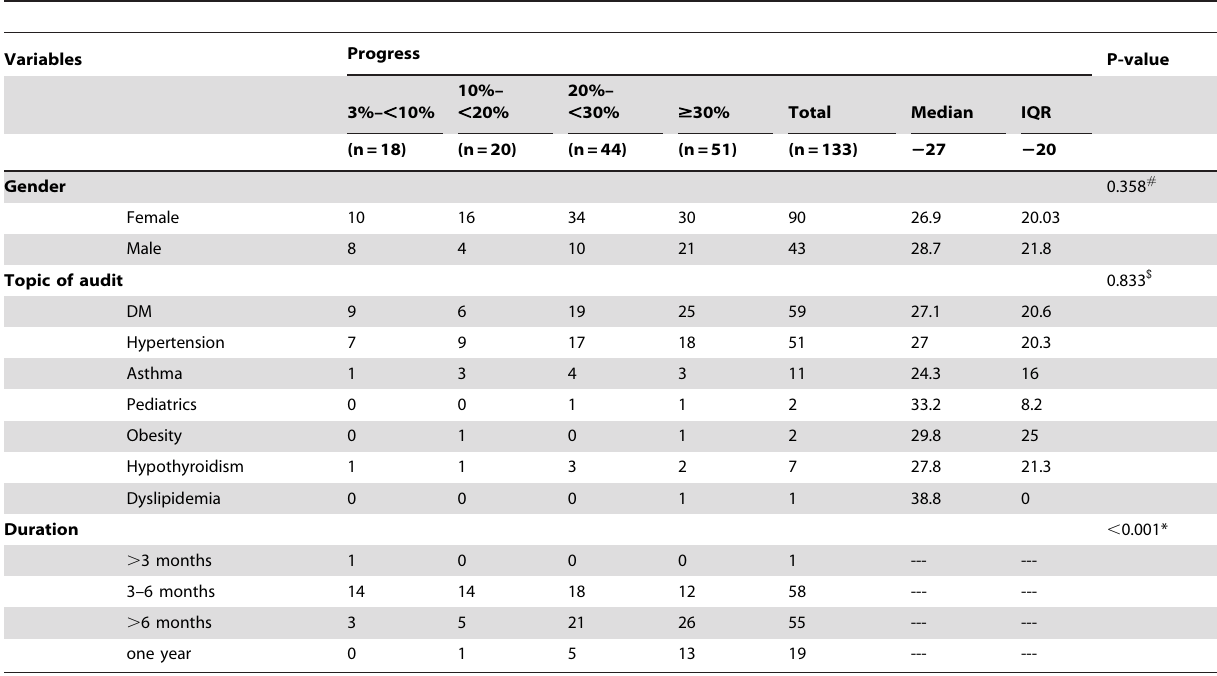
Table 2. Univariate analysis of the relationship between each of the trainee’s gender, topic and project duration with the progress achieved as a